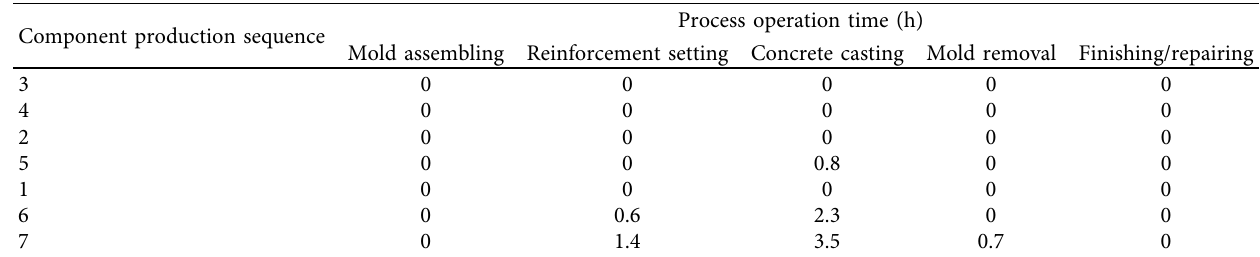
Table 7: Overtime plan for scheme